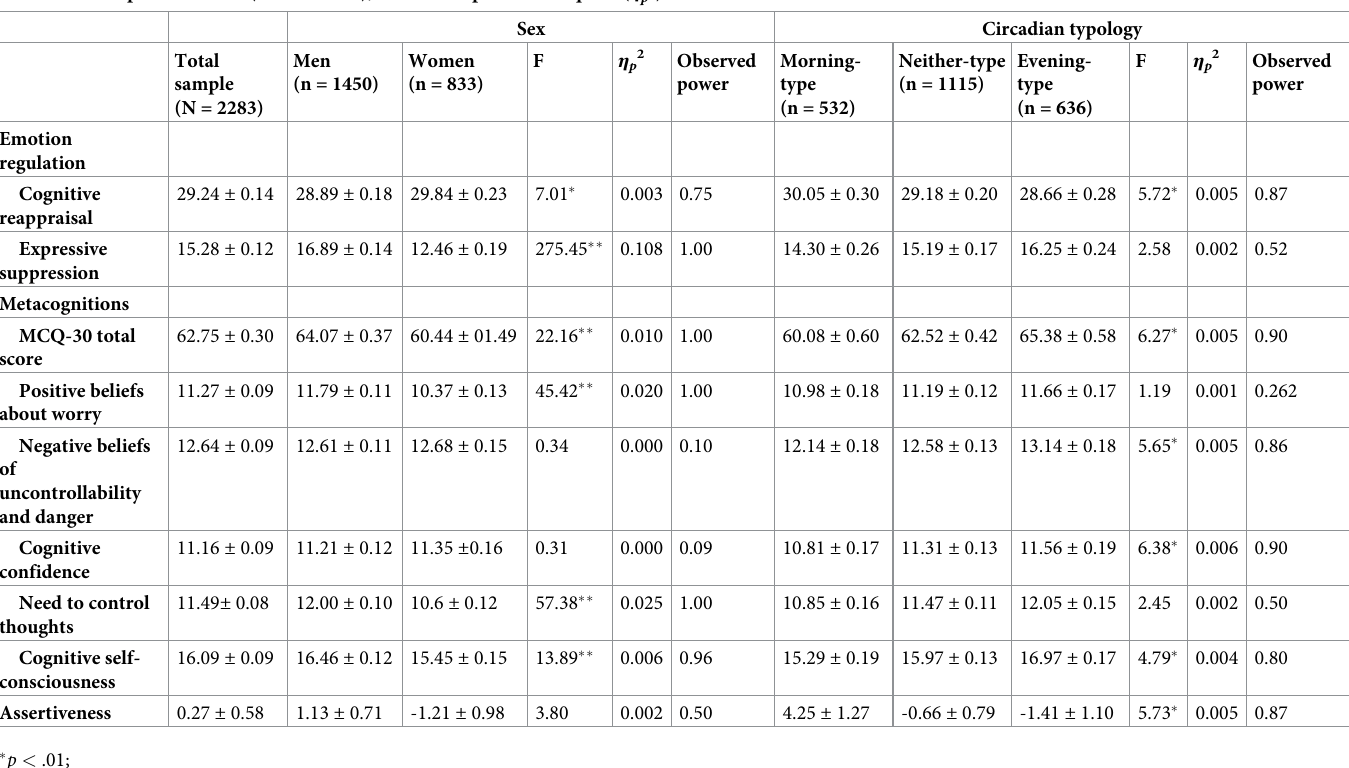
Table 2. Descriptive statistics (mean ± SEM), F-tests and partial eta-square ( η